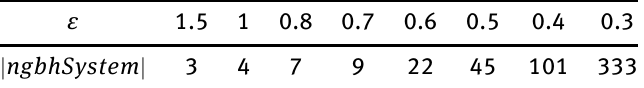
Algorithm 2: The algorithm performing iris